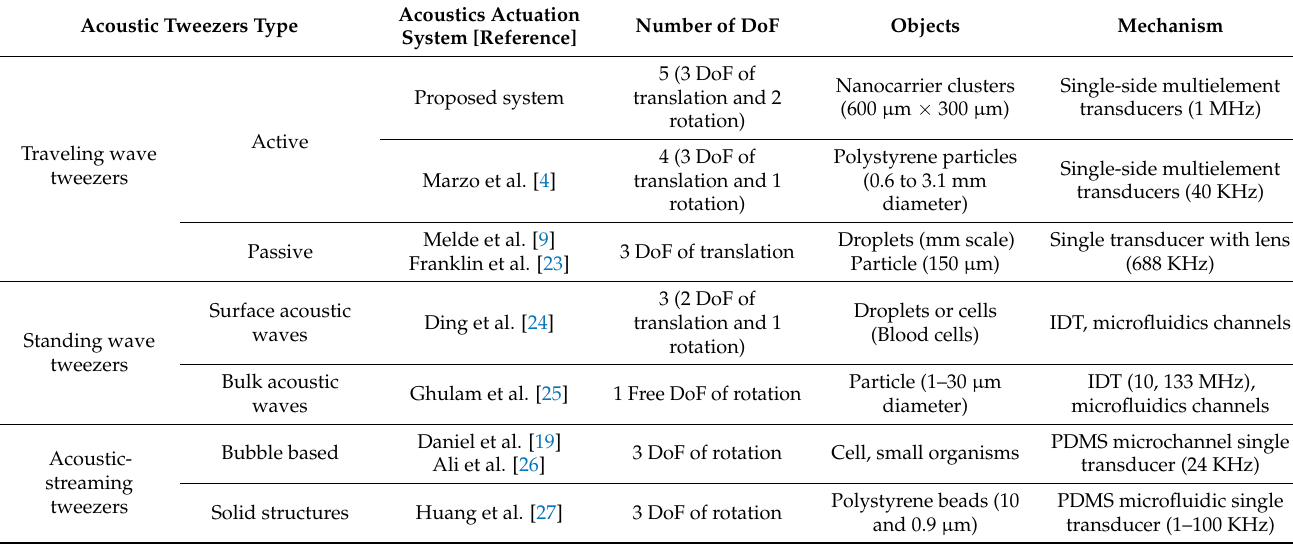
Table 1. Comparison between the proposed and recently developed